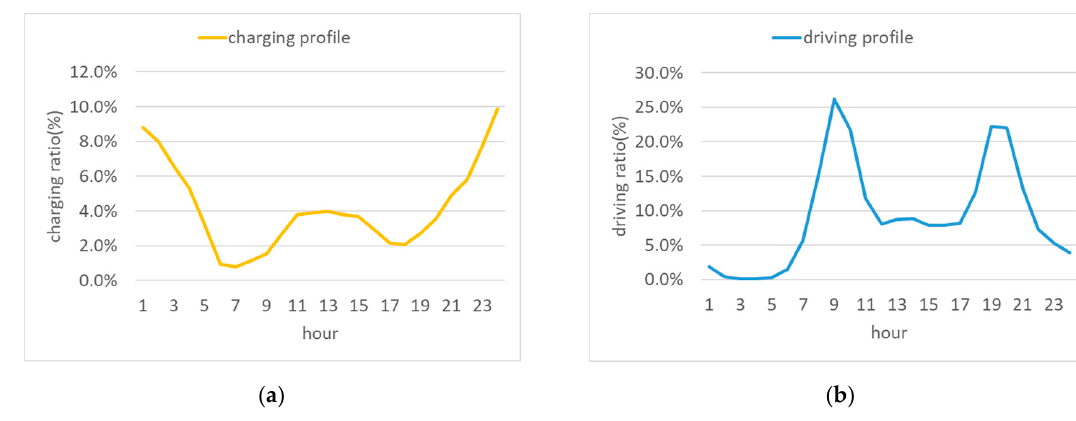
Figure 4. Charging ratio profile and driving profile of EVs for Jeju Island: ( a ) charging ratio profile; ( b ) driving profile.